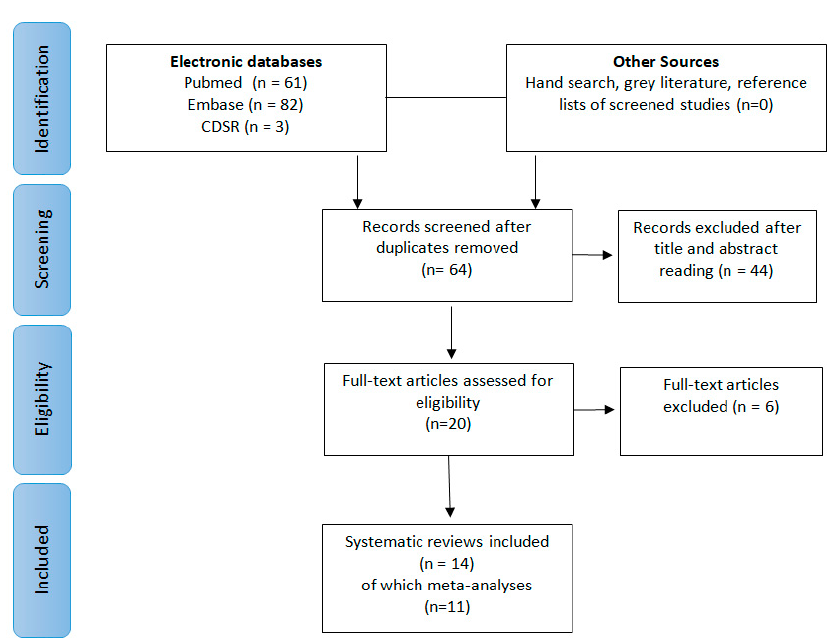
Figure 1. Preferred Reporting Items for Systematic Reviews (PRISMA) flow diagram of the study selection process.